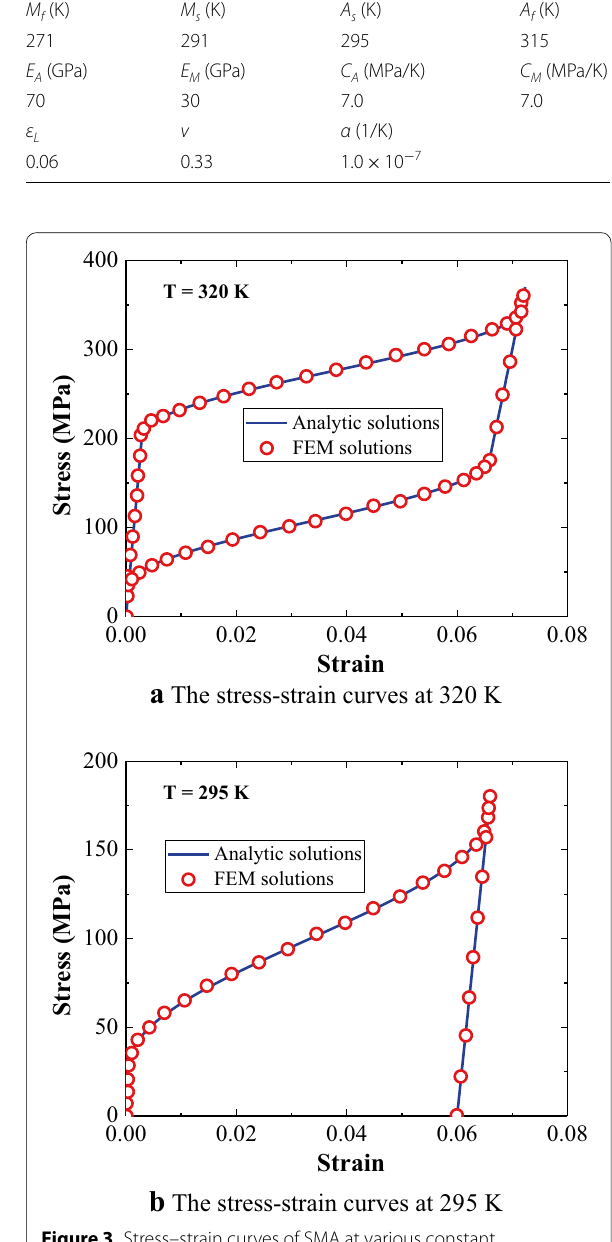
Figure 3 Stress–strain curves of SMA at various constant